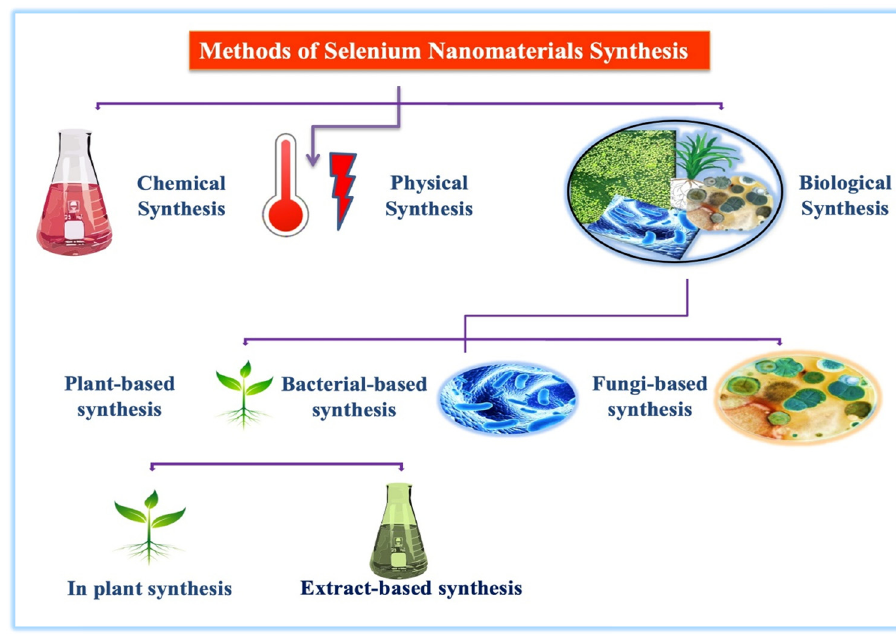
Figure 1: Various routes for the fabrication of SeNPs ( adapted from ref. [ 11 ])